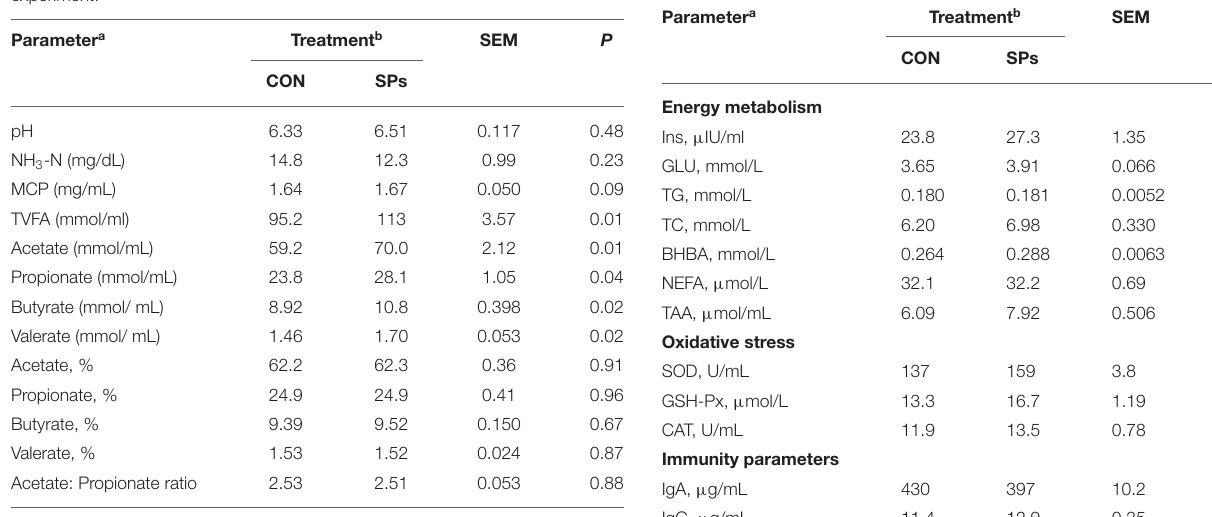
Treatment Treatment × Time